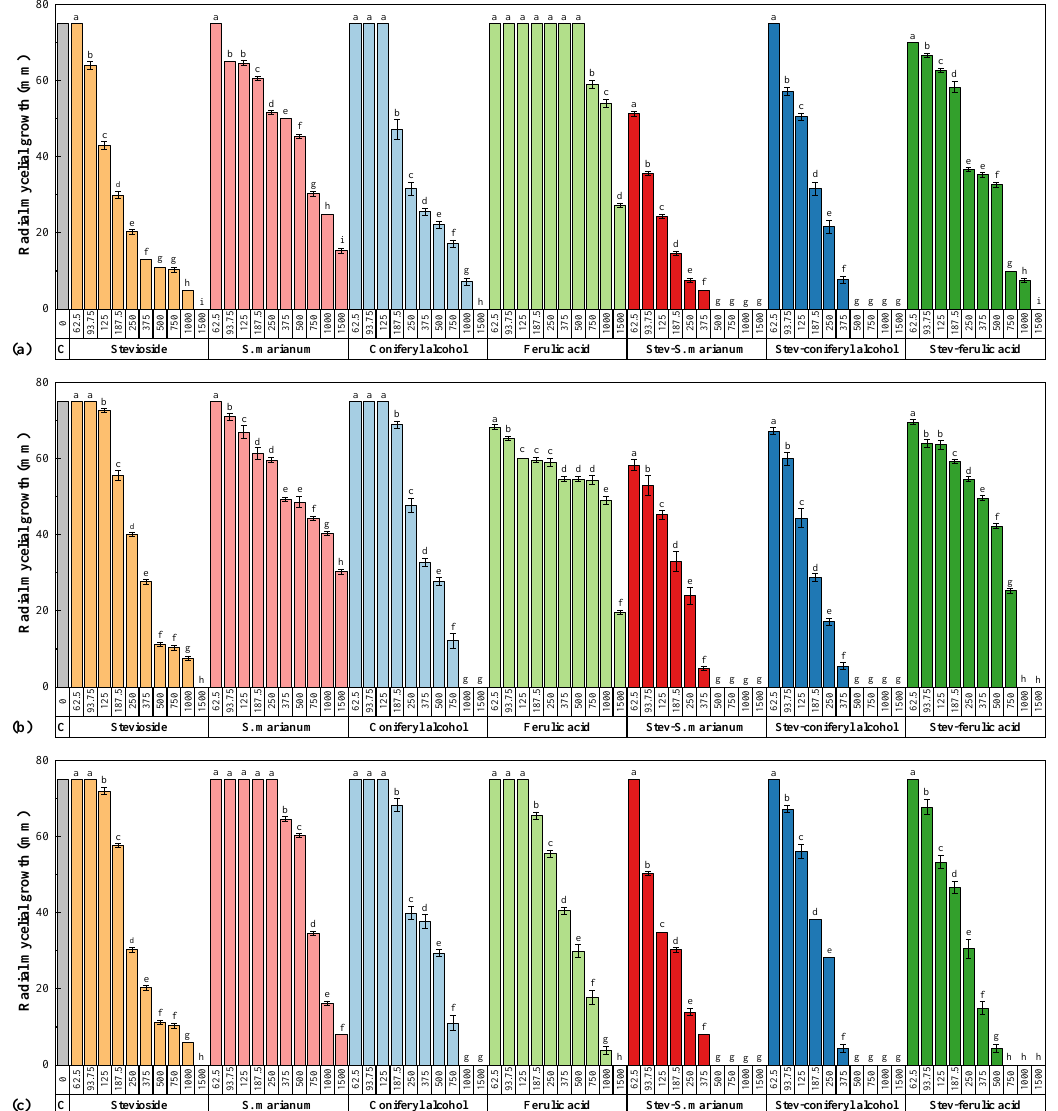
Figure 1. Colony growth measures of ( a ) N. parvum , ( b ) D. viticola , and ( c ) D. seriata strains when cultured in PDA plates containing the various control products (viz. stevioside, S. marianum hydromethanolic extract, coniferyl alcohol, ferulic acid, stevioside – S. marianum , stevioside – coniferyl alcohol and stevioside – ferulic acid conjugate complexes) at concentrations in the 62.5 –1500 μg·mL −1 range. The same letters above concentrations indicate that they are not significantly different at p < 0.05. Error bars represent standard deviations.